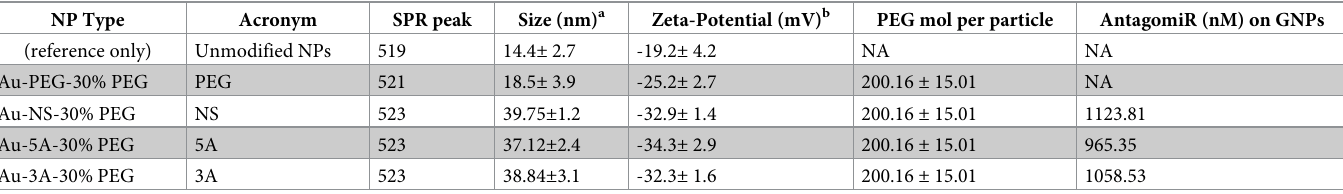
Table 3. Physical-chemical properties of the GNPs employed in the